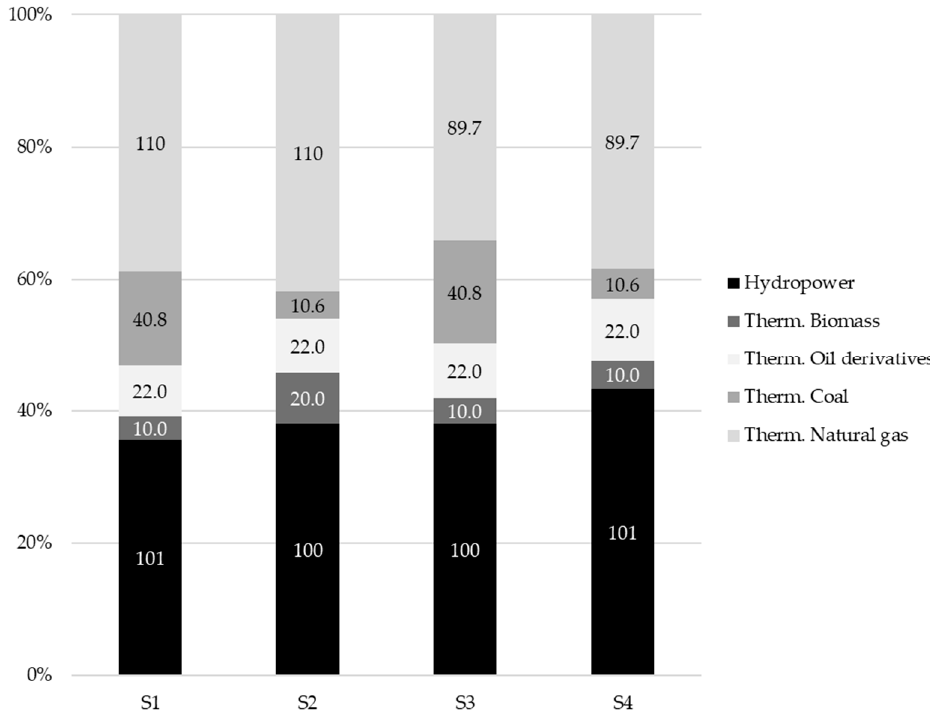
Figure 4. Contributions for Global Warming Potential by source of the Brazilian grid: relative (%) and absolute (kg CO 2eq /MWh) values.